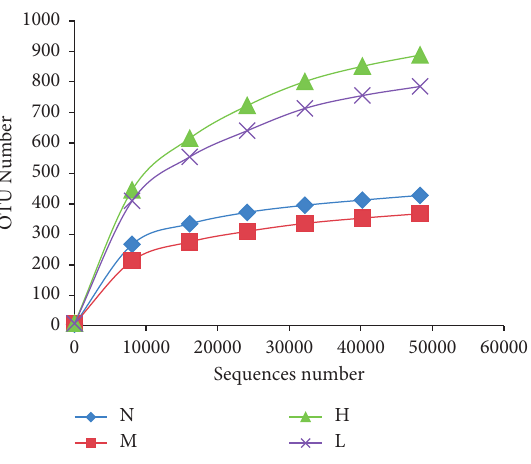
Figure 10: Number of species in each group.